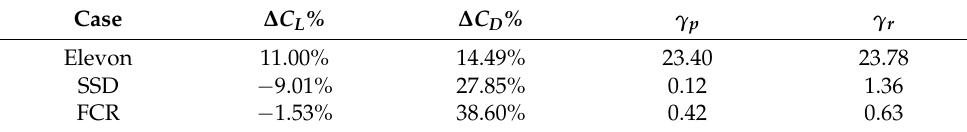
Table 8. Aerodynamic coefficients variation for the configurations at α = 6 ◦